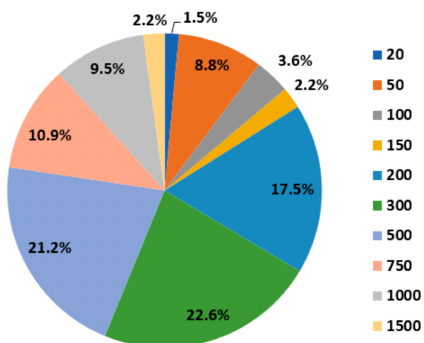
Figure 8. Frequency of the target illuminance values (lx) used for various industrial activities according to EN12464-1,